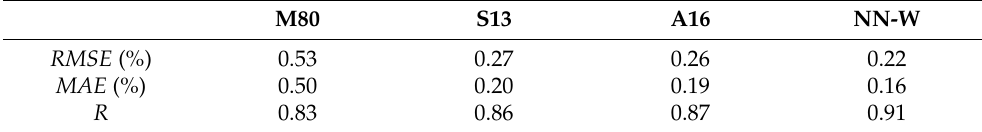
Table 2. Evaluation of the RMSE , MAE , and R metric in different parameterizations.